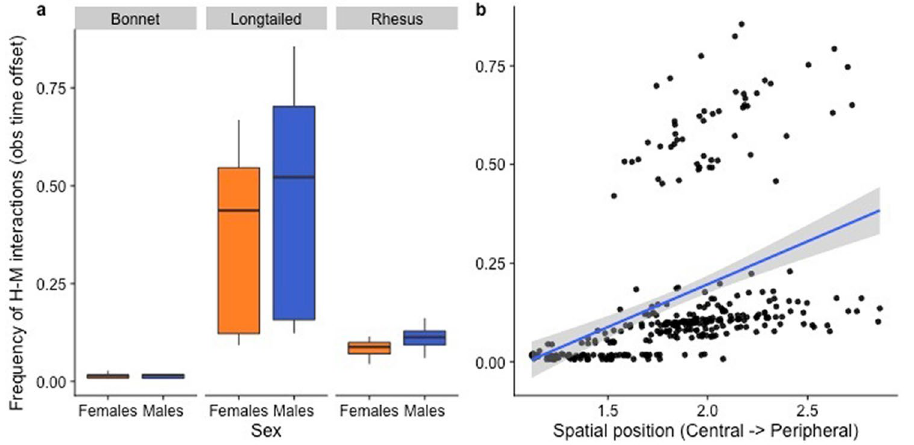
Figure 2. Effect of sex, species, and spatial position on the frequency of human–macaque interactions. The second grouping in the scatterplot represents individuals from two longtailed macaque groups included in the study that were observed at Batu Caves, where they experienced an exceptionally high frequency of human– macaque interactions (Y-axis) 43 . Figure was created using R (Version 3.6.1: https ://www.r-proje